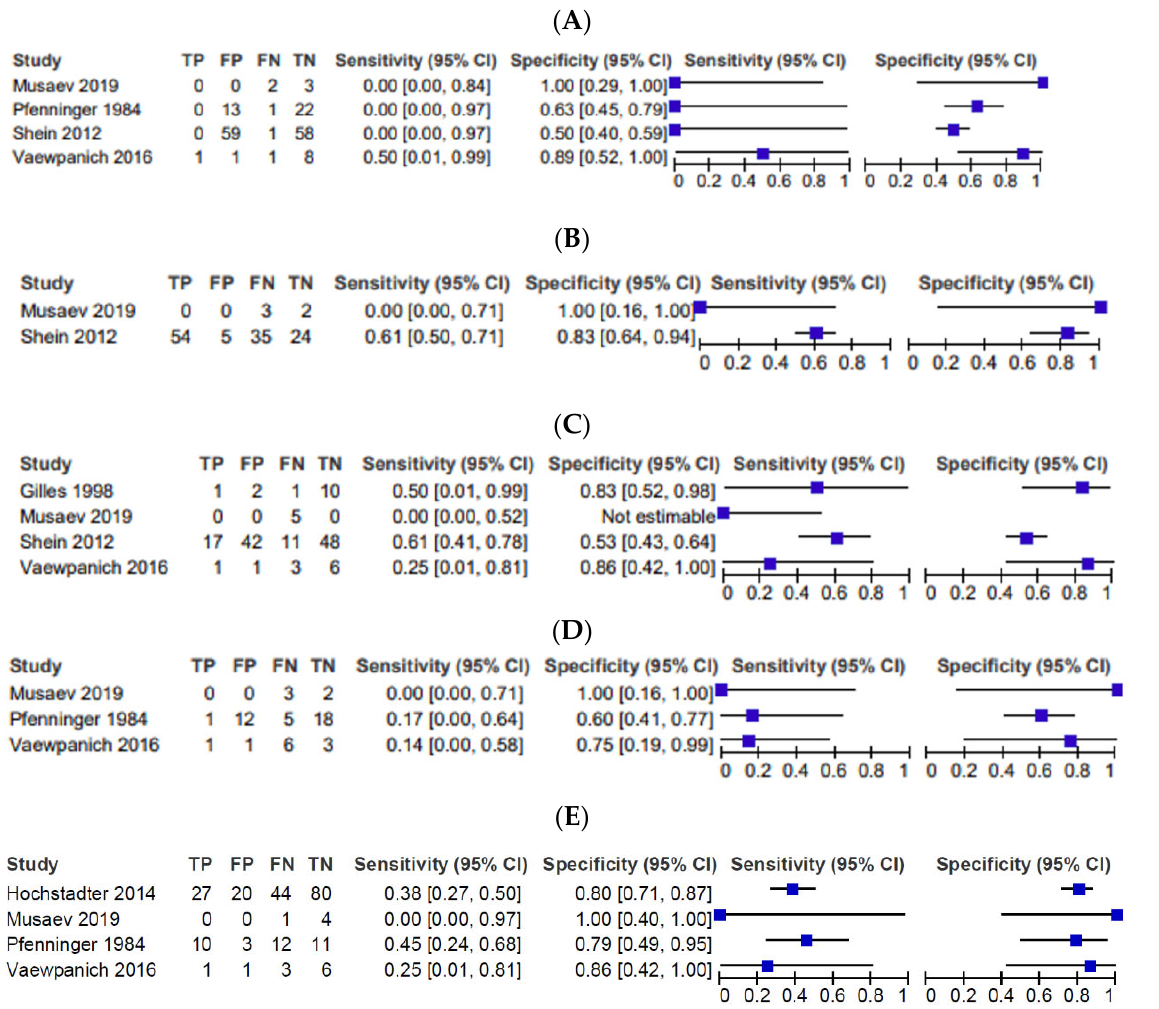
Figure 3. Forest plots for different imaging parameters for diagnostic accuracy of death vs. survival. ( A ) Forest plots showing the confidence interval for sensitivity and specificity of EDH. ( B ) Forest plots showing the confidence interval for sensitivity and specificity of edema. ( C ) Forest plots showing the confidence interval for sensitivity and specificity of skull fractures. ( D ) Forest plots showing the confidence interval for sensitivity and specificity of SDH. € Forest plots showing the confidence interval for sensitivity and specificity of tSAH.